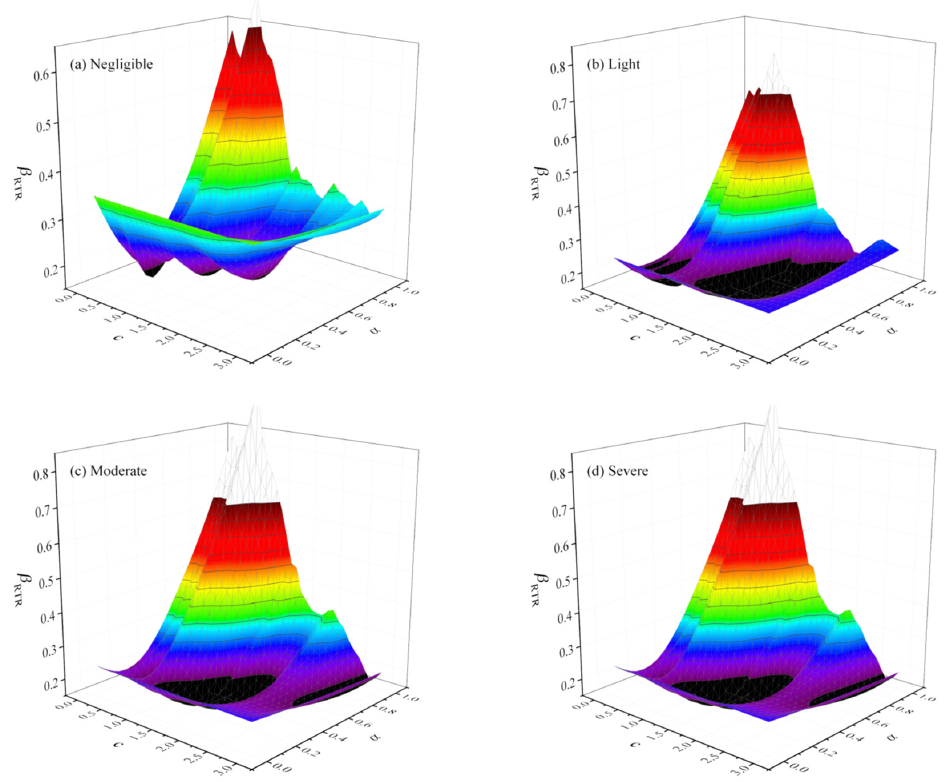
Figure 13. β RTR obtained using IM ∗ with different values of c and α under near-field earthquakes.